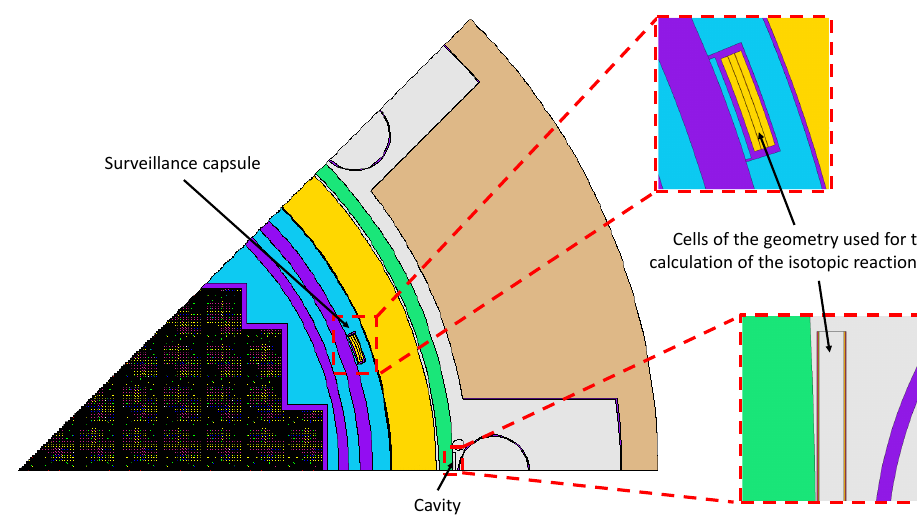
Figure 5. Radial cut of the MCNP6 modeling of the H.B. Robinson-2